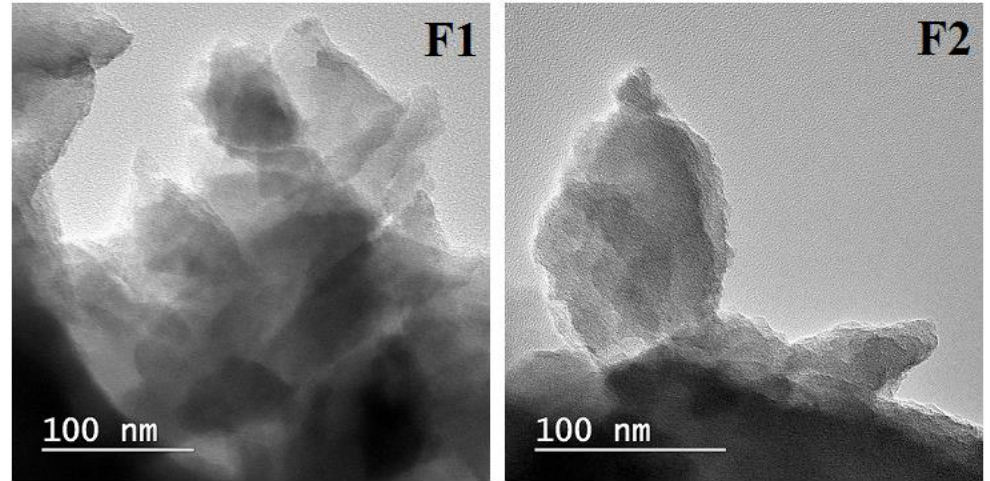
Figure 4. The TEM images of fluorinated silica materials (powdered samples): TEOS/MTES/FS (F1), and TEOS/MTES/HDTMES/FS (F2).